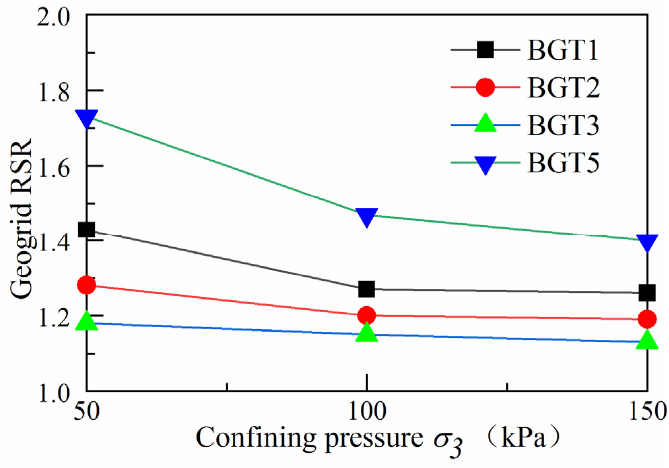
Figure 14. Geogrid reinforcement strength ratio.